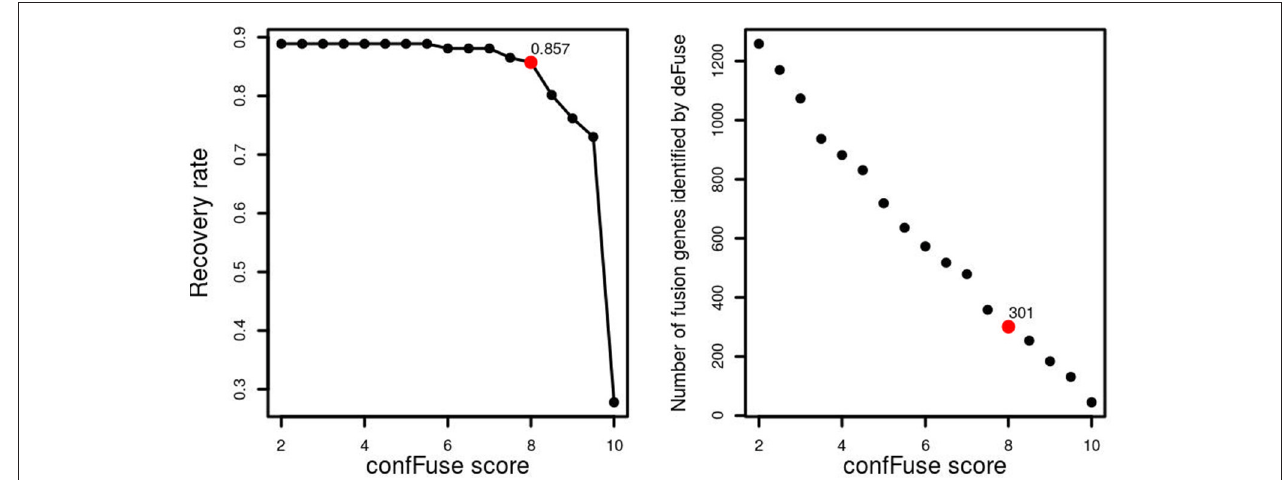
FIGURE 5 | confFuse score and recovery rate in 96 published samples. In total, 126 fusion genes were validated, 113 of which were identified by deFuse. confFuse detected 108 of 126 known validated fusions with score threshold 8. The right-hand figure shows the correlation between confFuse score and the number of fusions identified by deFuse.